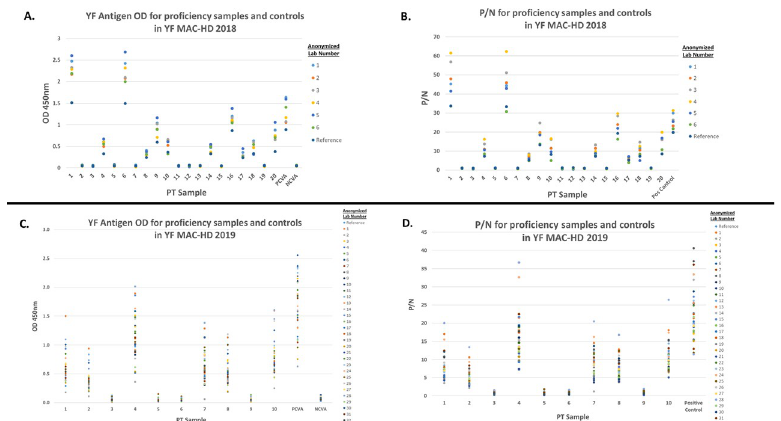
Fig 2. Individual Laboratory YF MAC-HD OD and P/N Values for the 2018 and 2019 Yellow Fever Proficiency Testing Exercises. A. Comparison of individual PT sample YF antigen OD values across six anonymized laboratories that participated in the 2018 YF PT Exercise. Note that the 7 th laboratory submitted interpreted results but did not provide OD values. B. Comparison of individual PT sample P/N values across six anonymized laboratories that participated in the 2018 YF PT Exercise. Note that the 7 th laboratory submitted interpreted results but did not provide P/N values. C. Comparison of individual PT sample YF antigen OD values across 32 anonymized laboratories that participated in the 2019 YF PT Exercise. D. Comparison of individual PT sample P/N values across 32 anonymized laboratories that participated in the 2019 YF PT Exercise. Abbreviations: YF–yellow fever; PT–proficiency testing; OD–optical density; P/N–defined as the mean OD of the sample reacted on YF antigen divided by the mean OD of the negative control reacted on YF antigen; PCVA–positive control reacted on YF viral antigen; NCVA–negative control reacted on YF viral antigen.